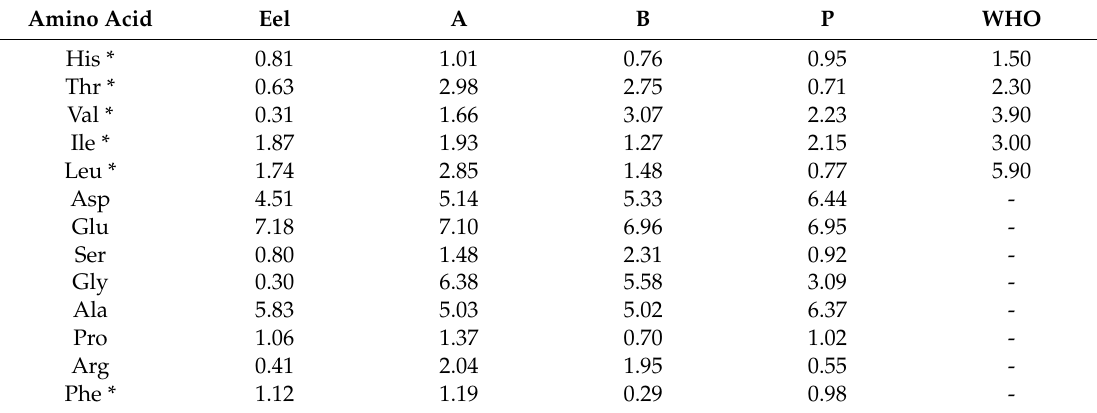
Table 2. Total amino acids of the three EPHs (A = alcalase, B = bromelain, P = papain) and recommended amino acid requirements of adults (WHO, 2002). Branched chain amino acids are highlighted in bold font. WHO = World Health Organization.